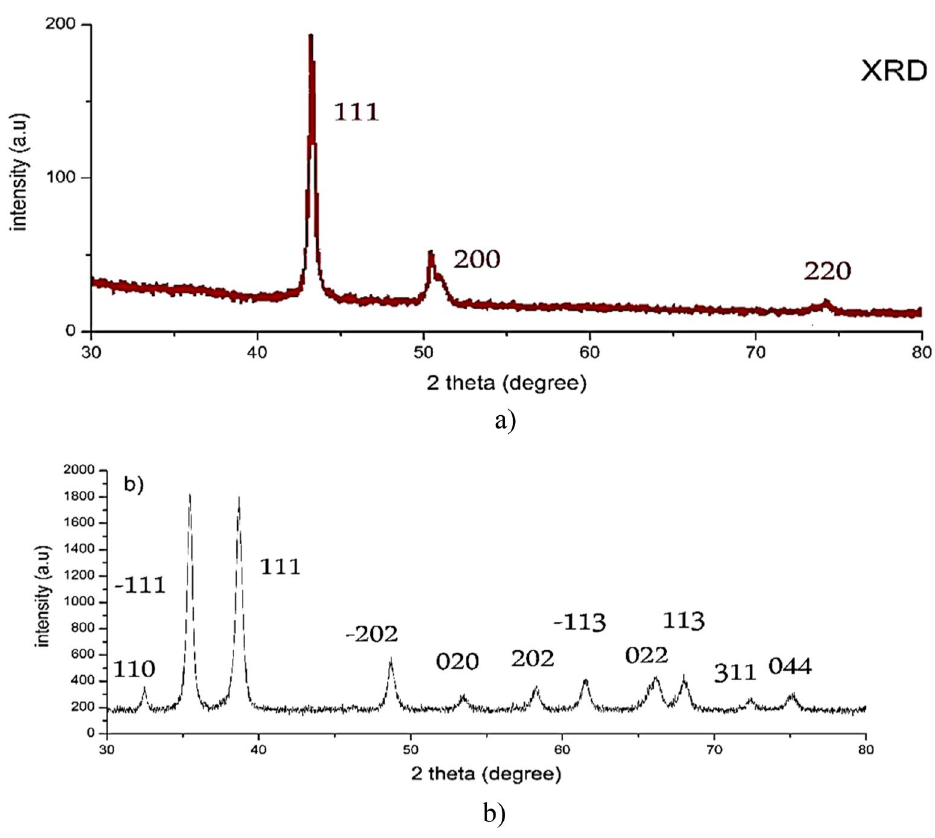
Figure 3. XRD pattern of ( a ) CuO-NWs and ( b )